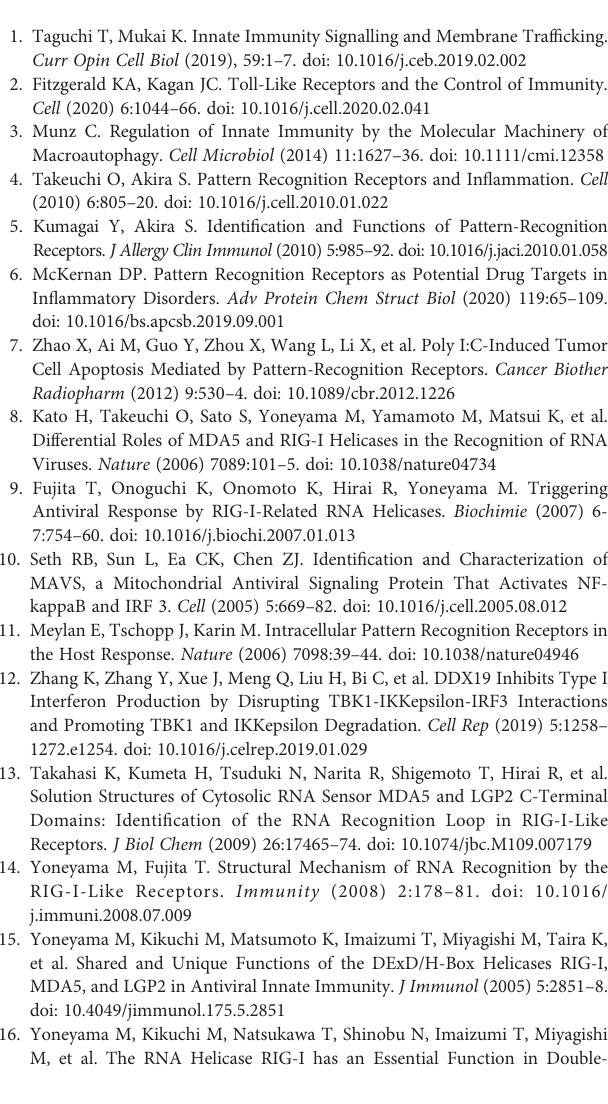
Supplementary Figure 1 | Phylogenetic analysis of Mex3A. Phylogenetic tree was generated by Mega 6.0 program. The result was based on the multiple sequencealignmentusing theClustalXprogram.Thebarswere1000assessments of bootstrap to determine the con fi dence level. CiMex3A was marked with black triangle. Supplementary Figure 2 | The location analysis of RIG-I. To further explore the location of RIG-I in cells. CIK cells were separately co-transfected with indicated plasmids. Then, the photos were taken under 63× oil immersion using Zeiss confocal microscope. The results are representatives of three independent experiments. The bars show 10 m